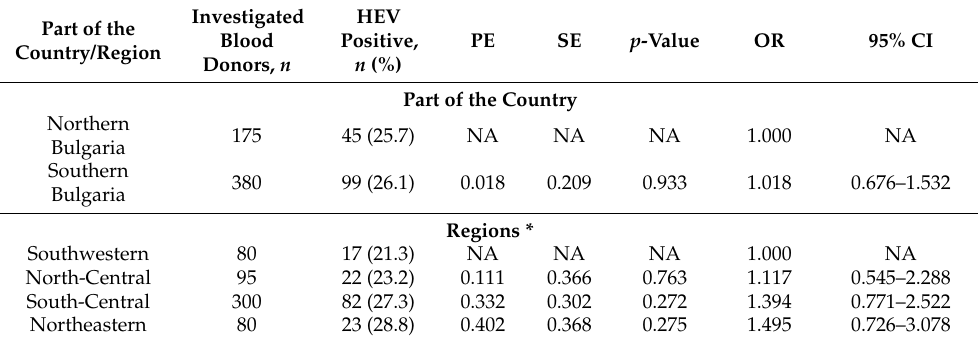
Table 3. Logistic regression showing the relationship between HEV positive blood donors and the geographic